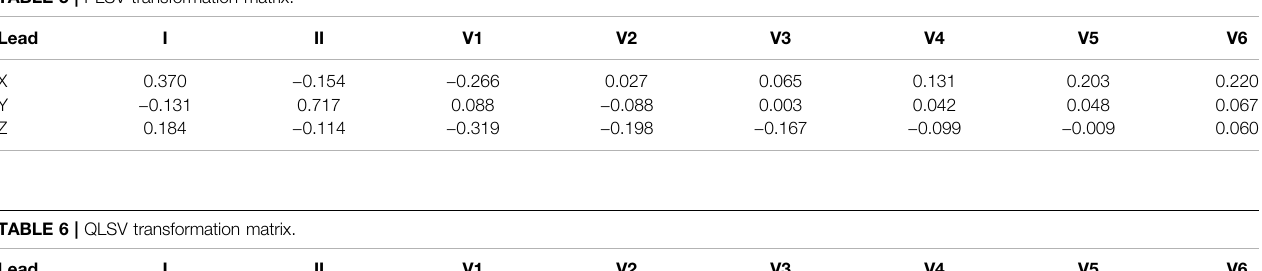
TABLE 5 | PLSV transformation matrix.